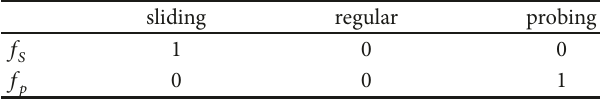
Table 2: Relationship between gait and gait transition